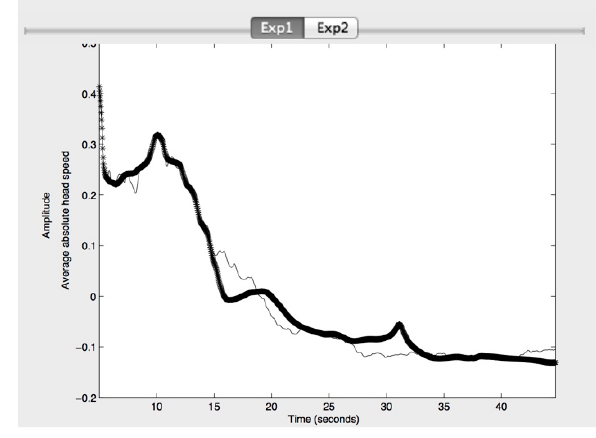
Figure 5. Facial expression extraction using LBP-optical flow tracker. (a) Extracted facial feature points. (b) Corresponding optical flow in Middlebury color-coding.